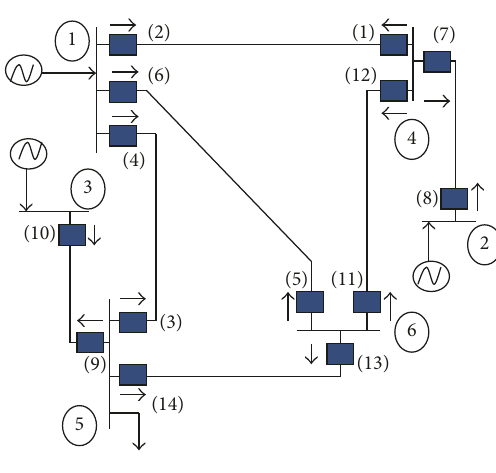
Figure 3: The 6-bus